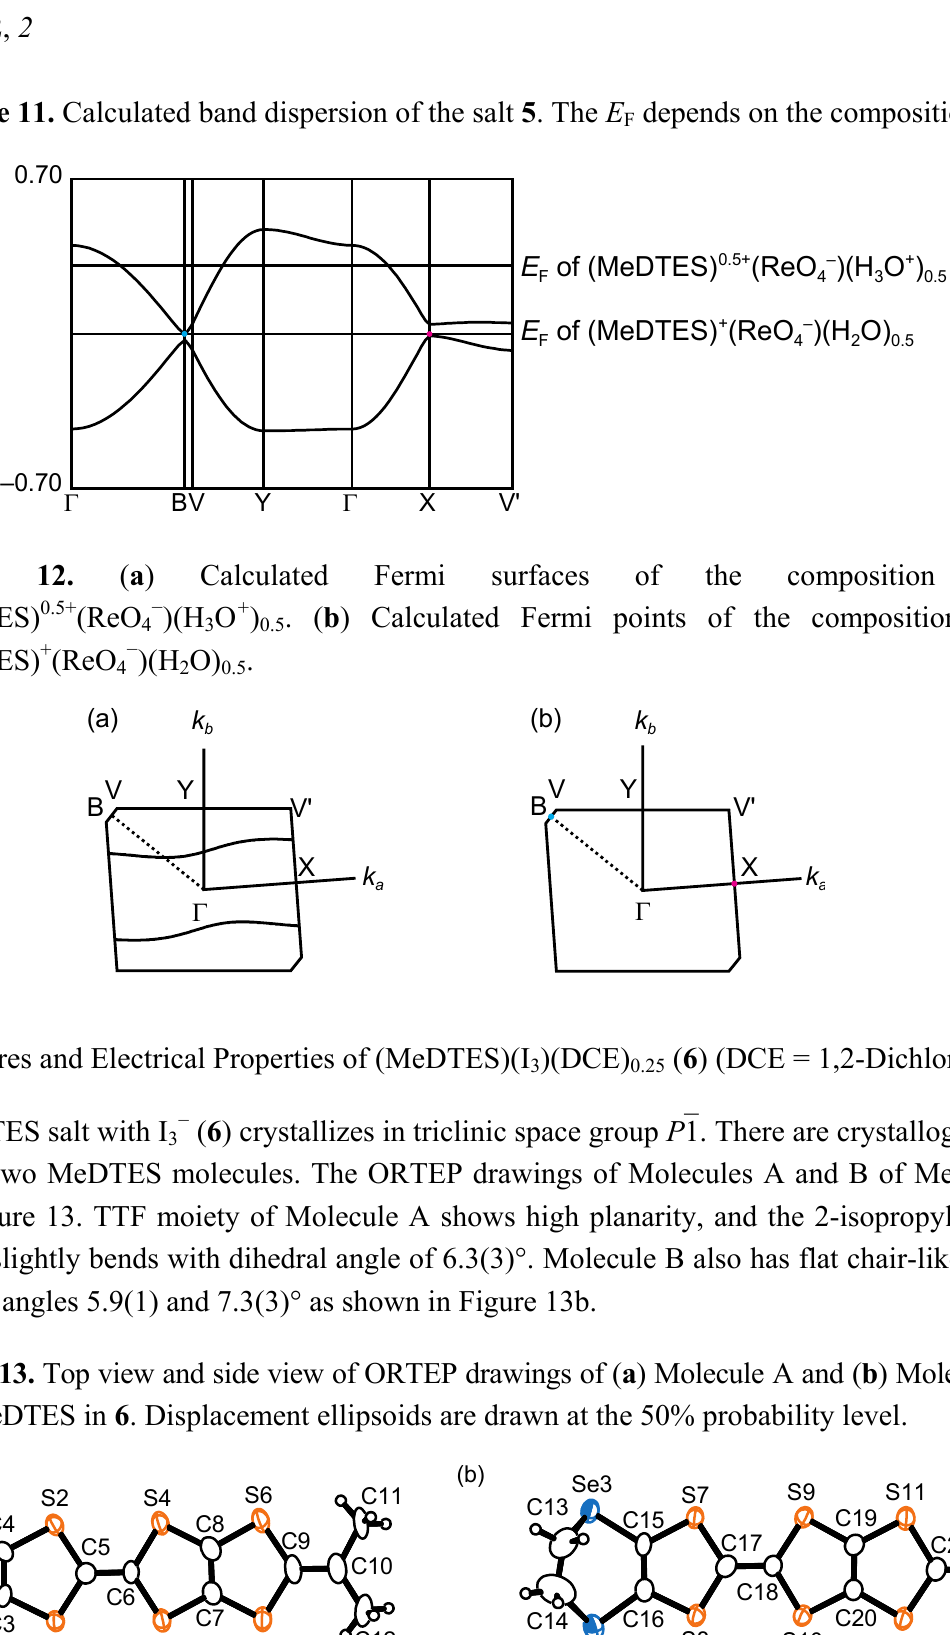
O + ) 3 0.5 O) 2 0.5